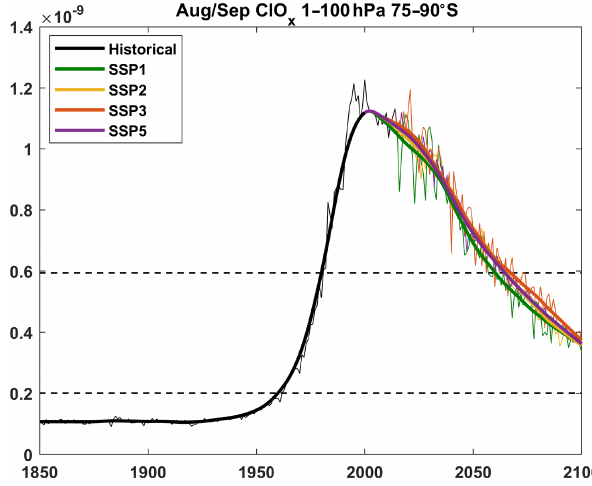
Figure 2. Same as Fig. 1 for the August/September mean volume mixing ratio of ClO x in the Antarctic stratosphere